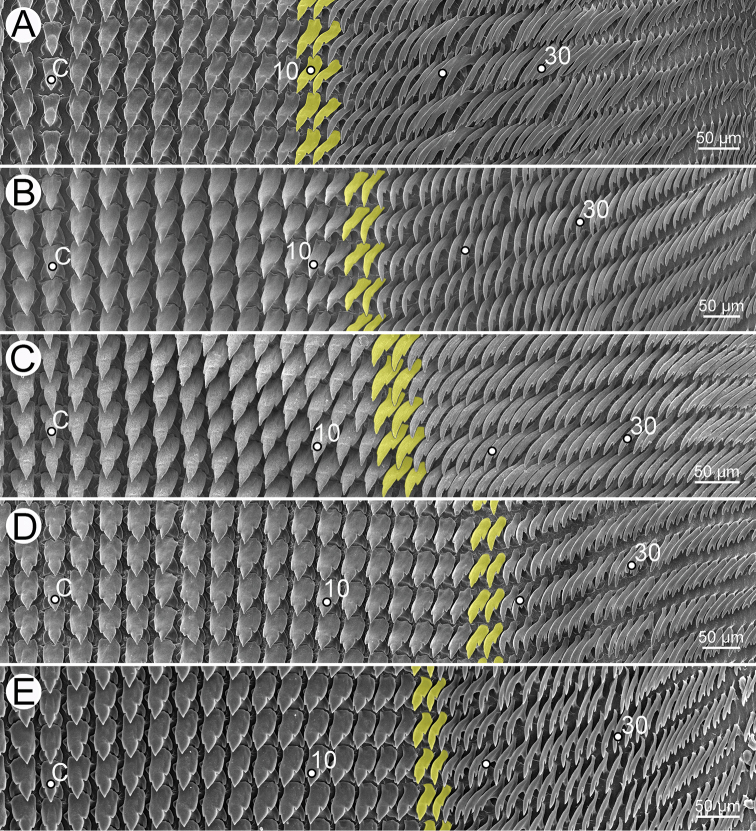
Representative SEM images of the radula. ASarika
hainesi specimen CUMZ 7237 BS.
bocourti specimen CUMZ 7597 CS.
inferospira sp. nov. paratype CUMZ 7255 DS.
melanospira sp. nov. paratype CUMZ 7243, and ES.
pellosa sp. nov. specimen CUMZ 7251. Central tooth indicated by ‘C’; Yellow colour indicates lateral teeth with the transition to marginal teeth.